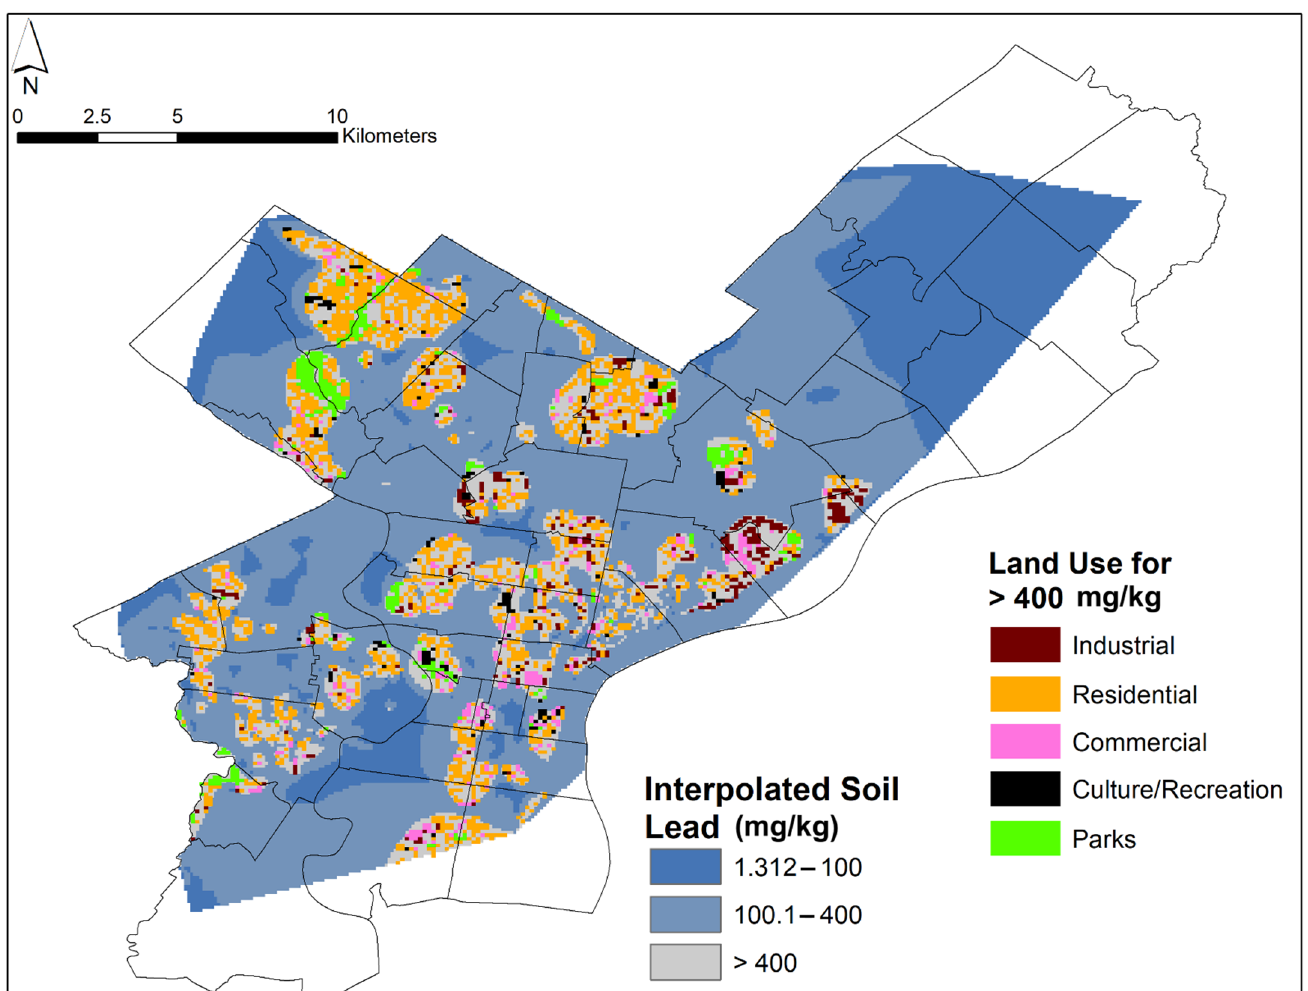
Figure 9. Map of Philadelphia displaying the interpolated Pb-in-soil contents grouped by land use. Areas with Pb ≥ 400 mg/kg are color-coded for their corresponding land use (industrial, parks, residential, culture/recreation, and commercial). Grey areas with Pb ≥ 400 mg/kg correspond to a type of land use not included in this study.